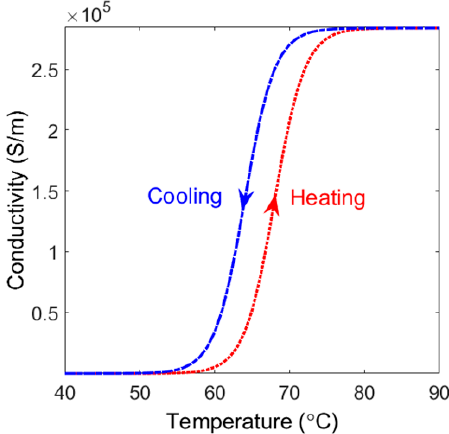
Figure 1. Conductivity of VO 2 during phase transition. The heating and cooling processes agree well with experimental data [23].